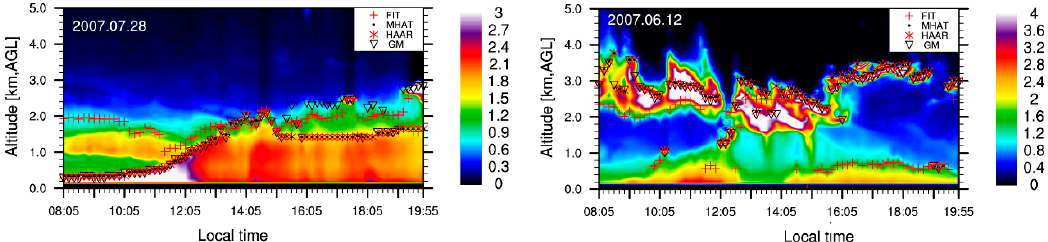
Figure 8. Time-height cross-section of the RSCS provided by the MPL over SACOL, with height directly determined from first-order gradient method (GM), HAAR/MHAT wavelet covariance transform, and ideal profile fitting (CFM) on 28 July 2007 and on 12 June 2007.